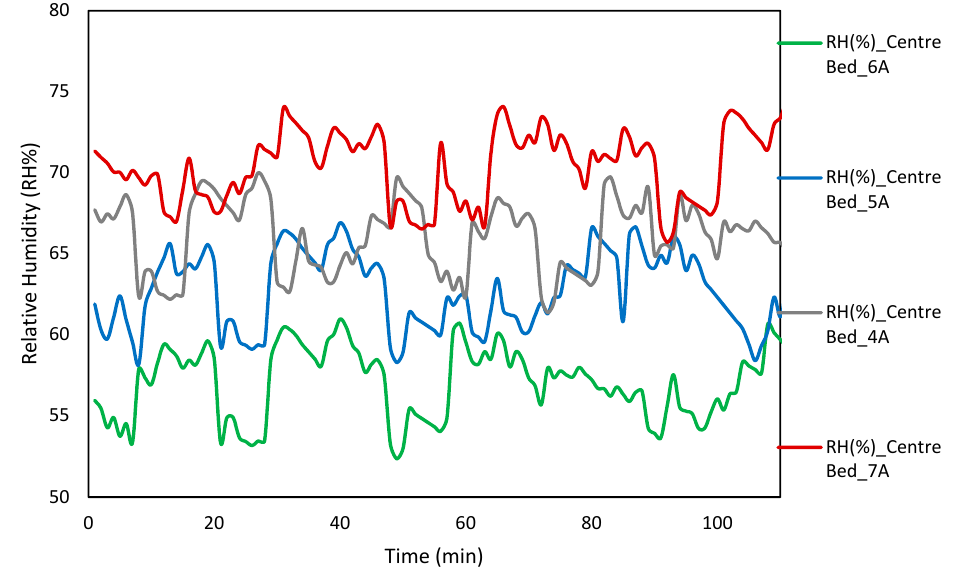
Figure 5. Variation of temperature at the center of the bed different power inputs. A further increment in the operating power input to the TE-AD system to 720 W decreased the temperature and relative humidity recorded close to the center of the bed by (M = 24.49 +/ − 0.94 °C, M = 55.48 +/ − 3.23). The temperature and relative humidity showed a rise when the operating power to the TE-AD system was raised from 720 W to 840 W, and the mean value increased to (M = 26.49 +/ − 1.12 °C, M = 68.731 +/ − 4.021).